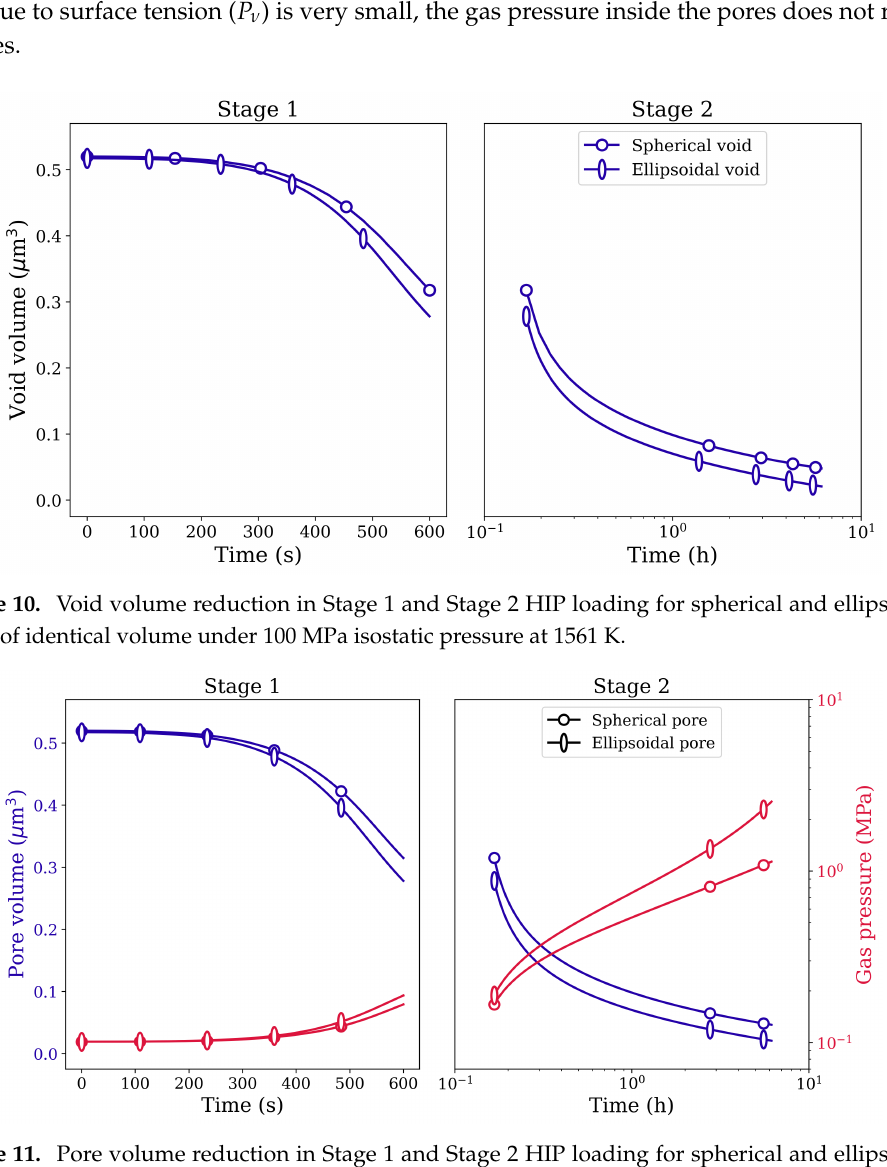
Figure 11. Pore volume reduction in Stage 1 and Stage 2 HIP loading for spherical and ellipsoidal pores of identical volume under 100 MPa isostatic pressure at 1561